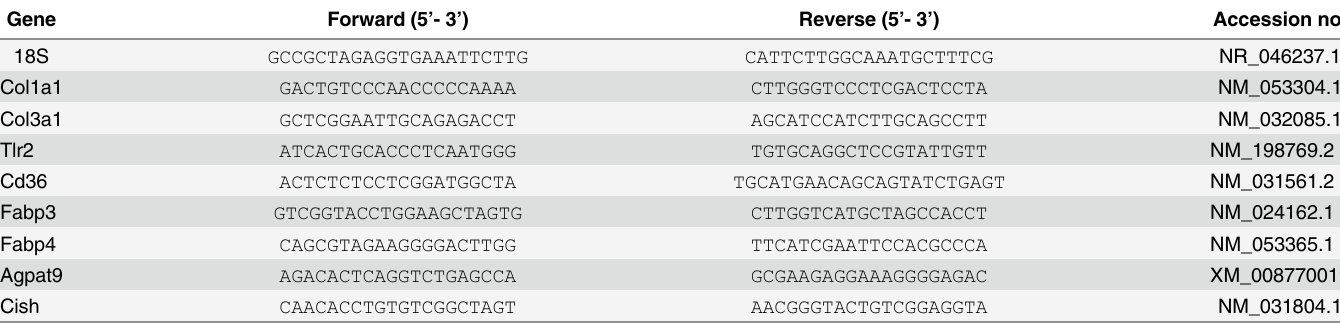
Table 1. Primer sequences for gene expression analyzed by